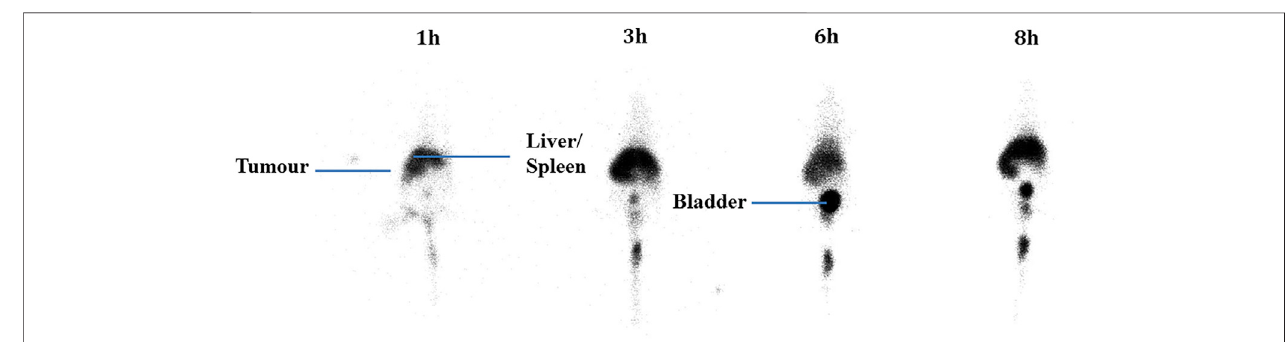
FIGURE 3 | Scintigraphic images acquired from a female nude BALB/c mice at 1, 3, 6 and 8 h post-injection with 200 µCi 99mTcO 4-